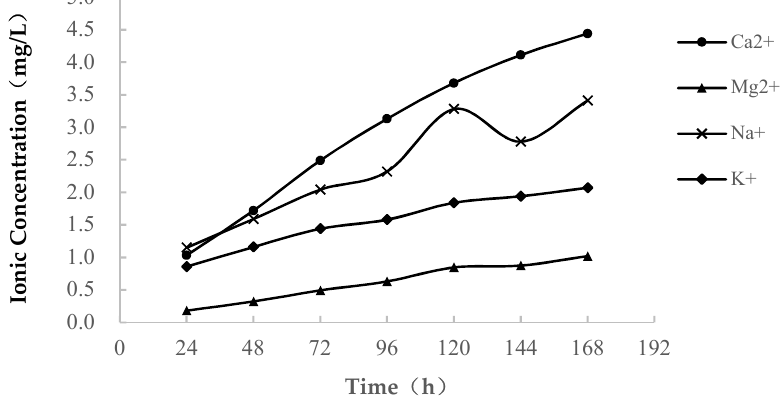
Figure 2. Concentration change curves of the main cations after pure water immersion.